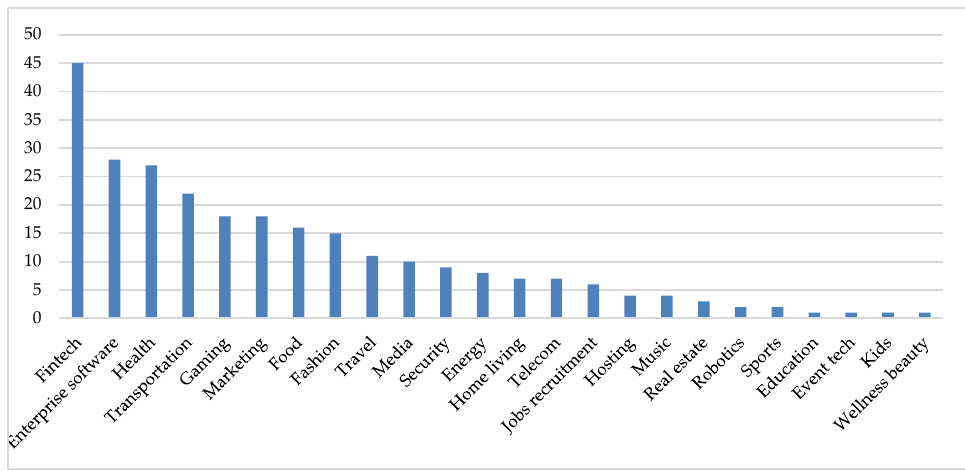
Figure 12. Industry-specific EU unicorns as of 2022. Source: Authors’ compilation, according to [71] and cumulative data.